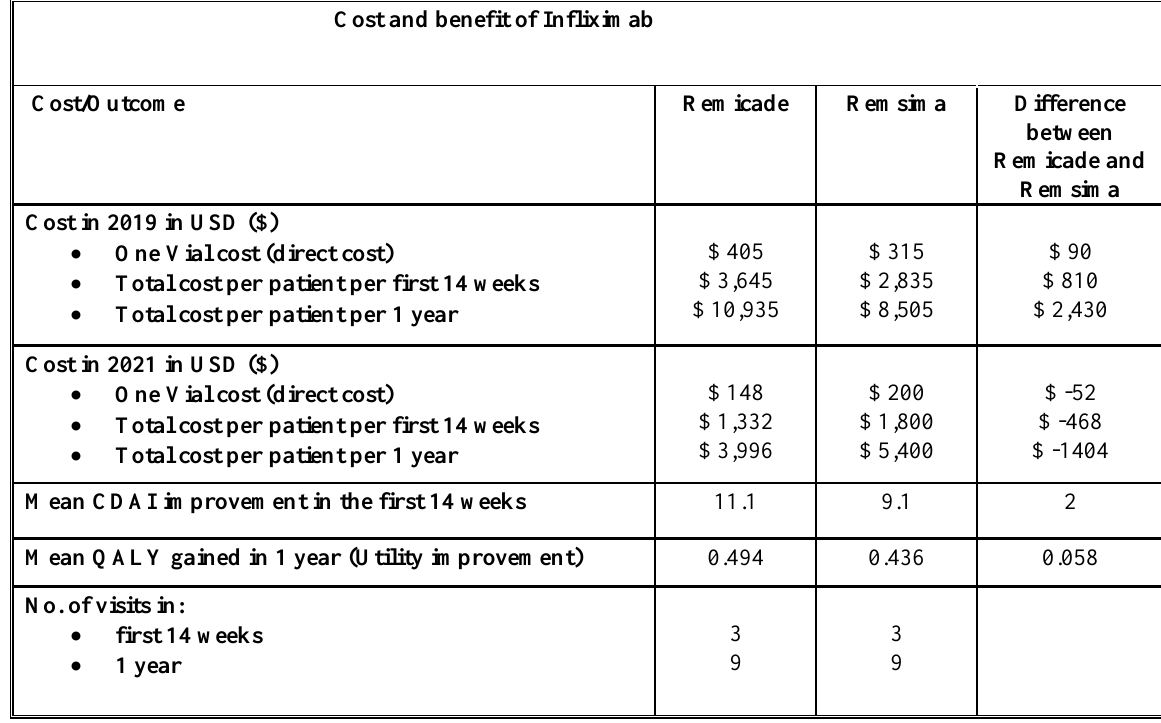
Table 10. Cost and benefit of Infliximab.